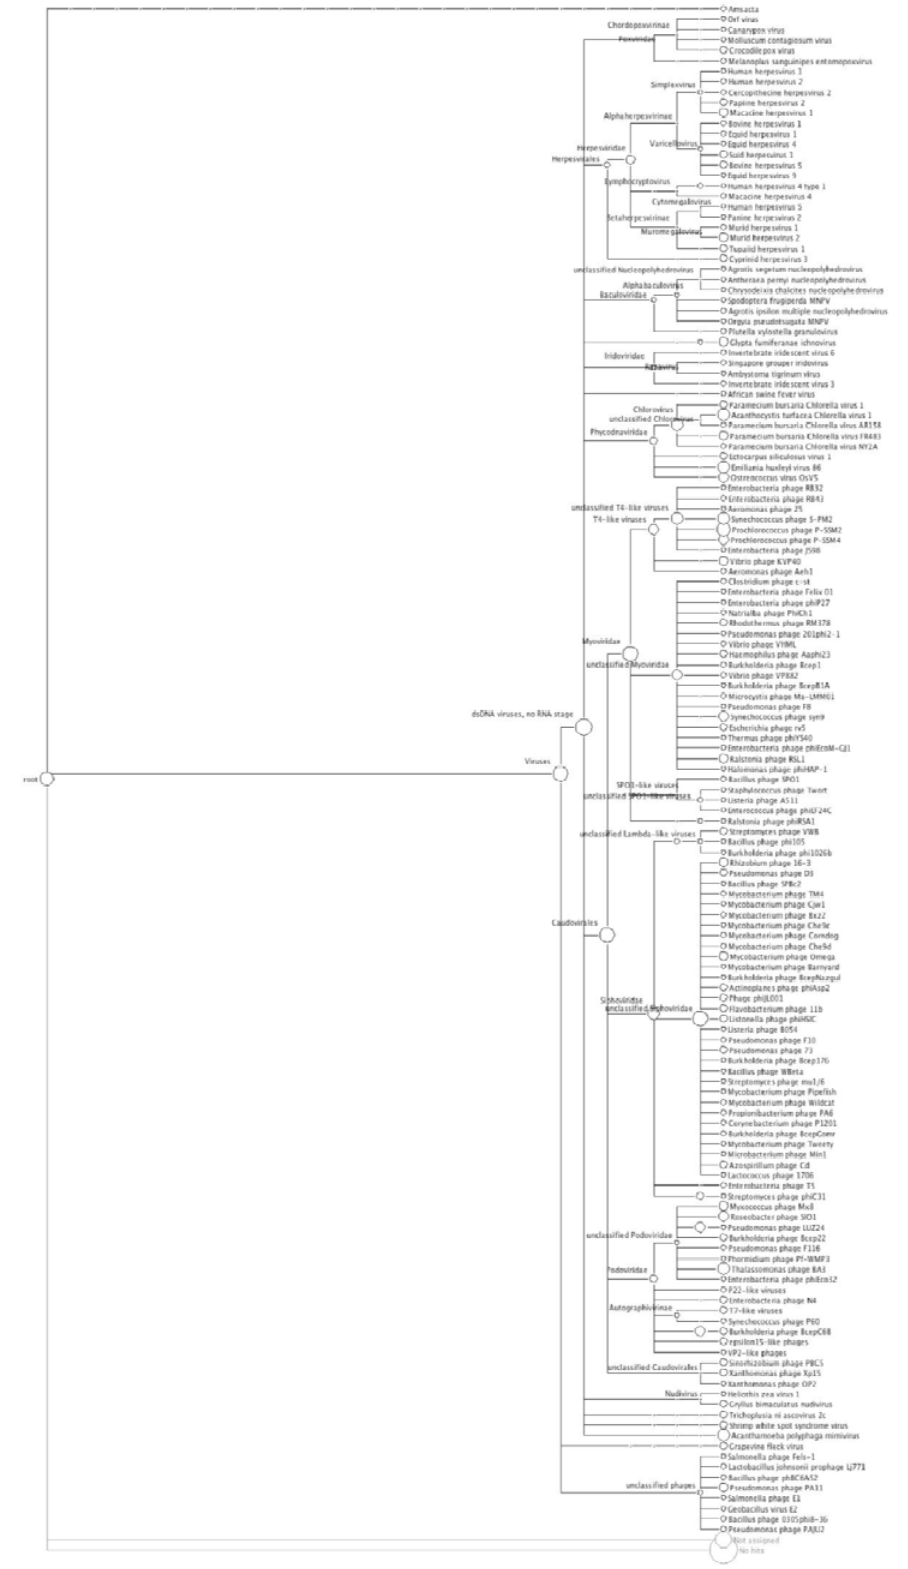
Figure 2. Phylogenetic diversity of the freshwater metagenome as calculated by MEGAN . Each circle represents a taxon in the NCBI taxonomy, and the size of the circle is scaled logarithmically to represent the number of reads assigned directly to the taxon. This Figure is also available as supplementary